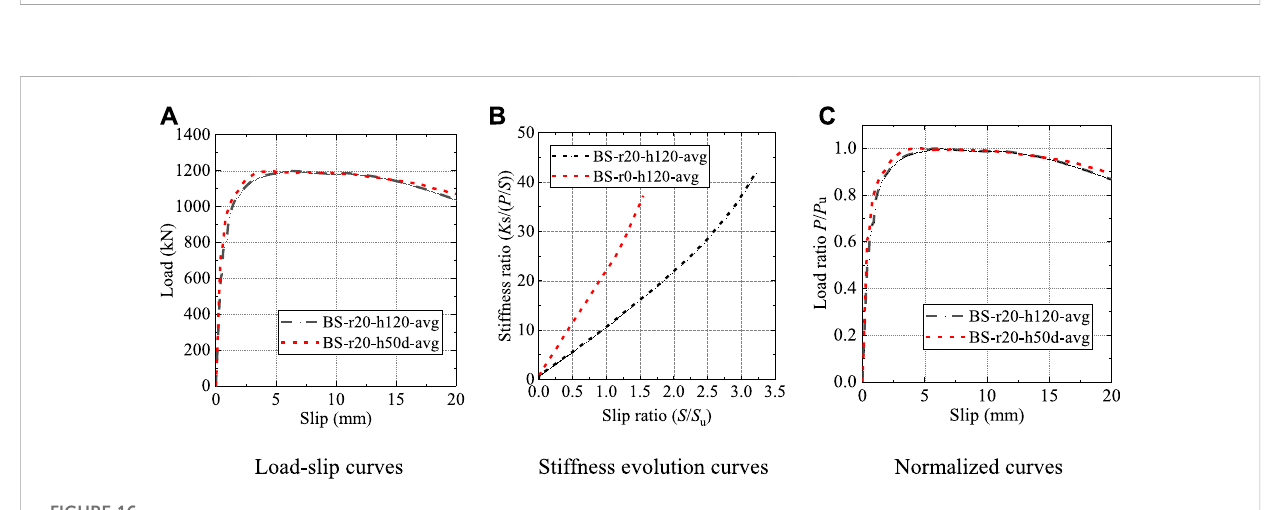
and FE analysis, the shear plates had a signi fi cant shear deformation, whereas the pressure-bearing plates had no obvious deformation. Figure 13 shows the comparison of